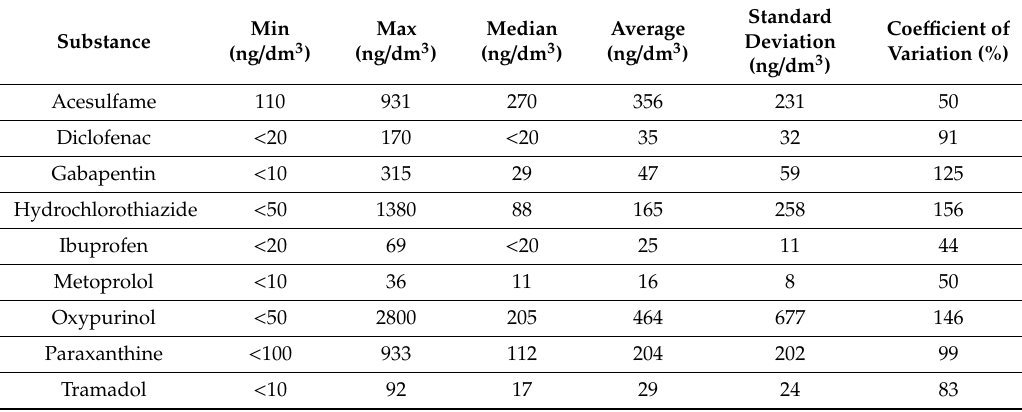
Table 10. Kacerov Profile — basic statistical parameters